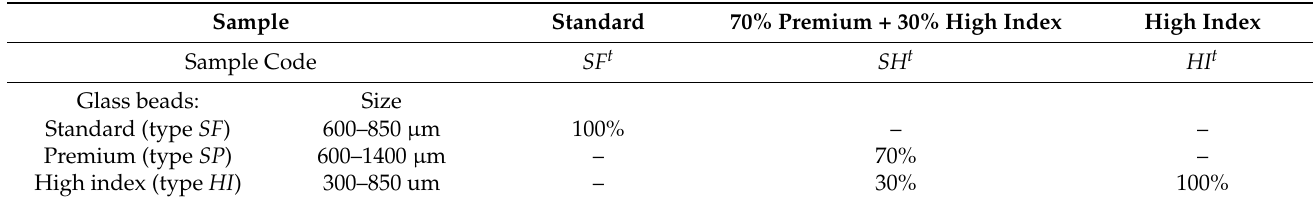
Table 3. Turntable evaluation: glass bead mixtures (weight